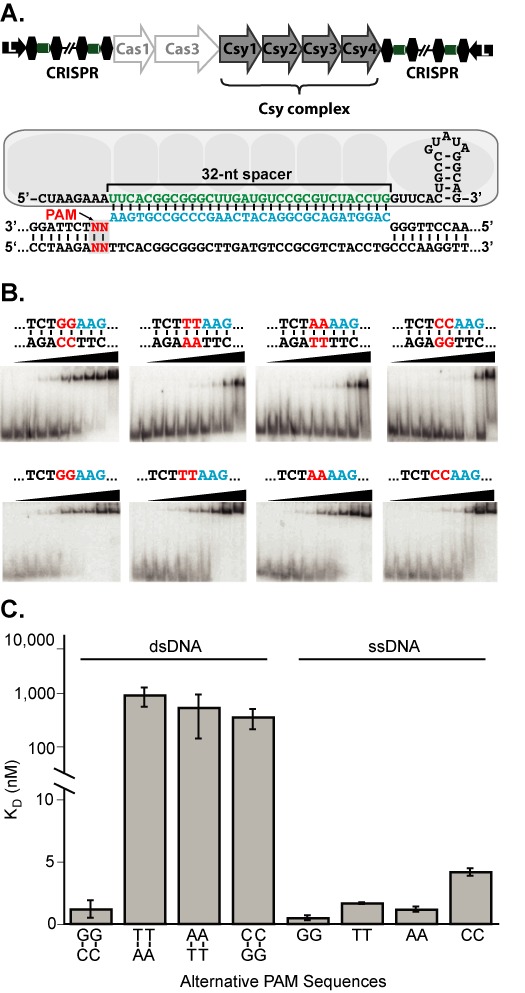
The Csy complex recognizes a double-stranded GC/GC PAM. (A) Organization of the CRISPR-Cas locus in the P. aeruginosa (PA14) genome and a schematic representation of the Csy complex. Csy protein subunits (light gray ovals) assemble with a crRNA, which includes a 32-nt spacer sequence (green). The Csy complex binds target DNA through direct hybridization between the crRNA spacer and a complementary target sequence (protospacer) (blue). The PAM (red) immediately 3′ of the protospacer is critical for crRNA-guide stand invasion in double-stranded DNA targets. (B) EMSAs performed with increasing concentrations of Csy complex (see ‘Materials and Methods' section) incubated with ssDNA or dsDNA 80-nt targets containing fully complementary protospacers and alternate PAM sequences (shown in red). Binding was quantified and plotted as a function of protein concentration, then fit with binding isotherms to determine equilibrium dissociation constants (KD) (see ‘Materials and Methods' section). (C) Binding affinities for Csy complex with dsDNA and ssDNA targets with alternate PAMs. Non-GG PAMs severely abrogated binding to dsDNA targets, but had comparably minor effects in ssDNA targets.